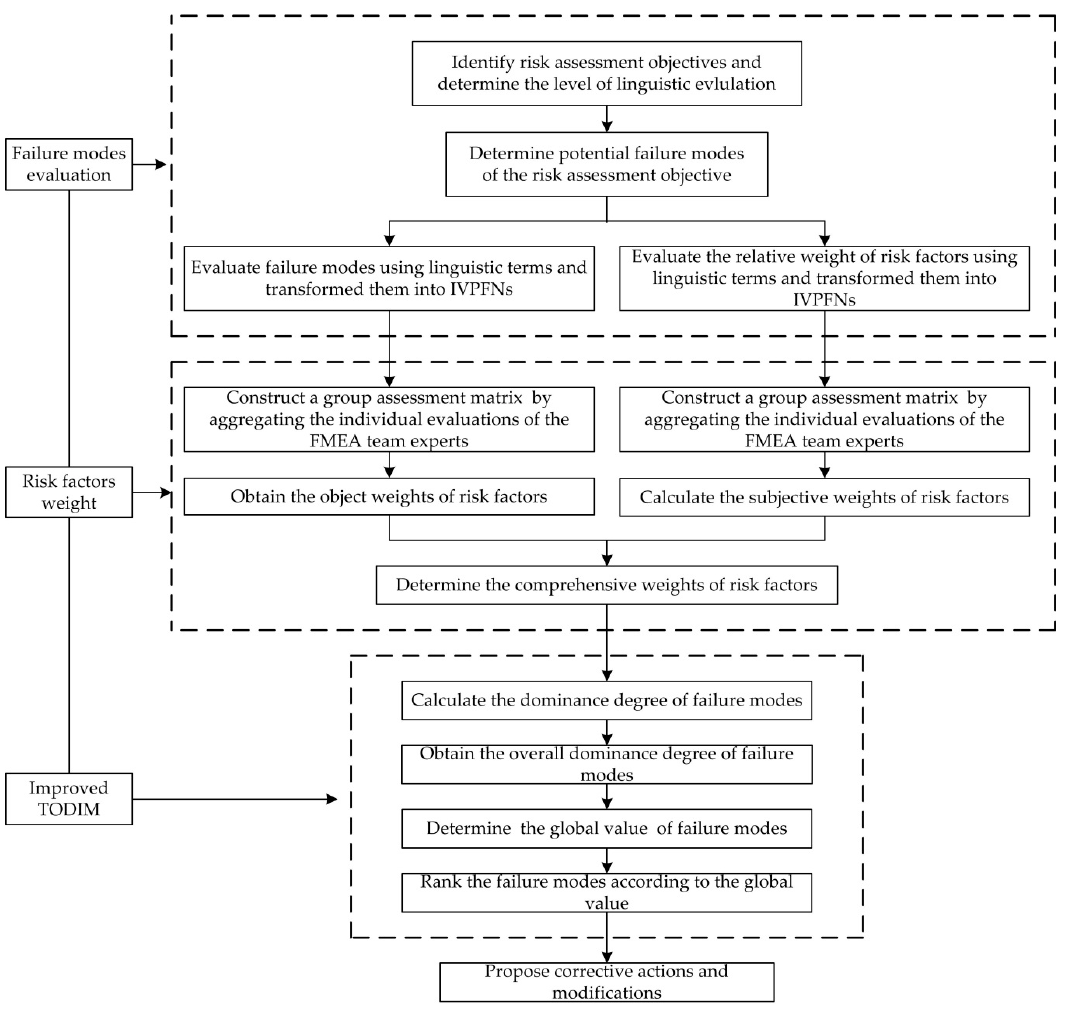
Figure 1. Flowchart of the proposed FMEA (Failure modes and effective analysis) model.